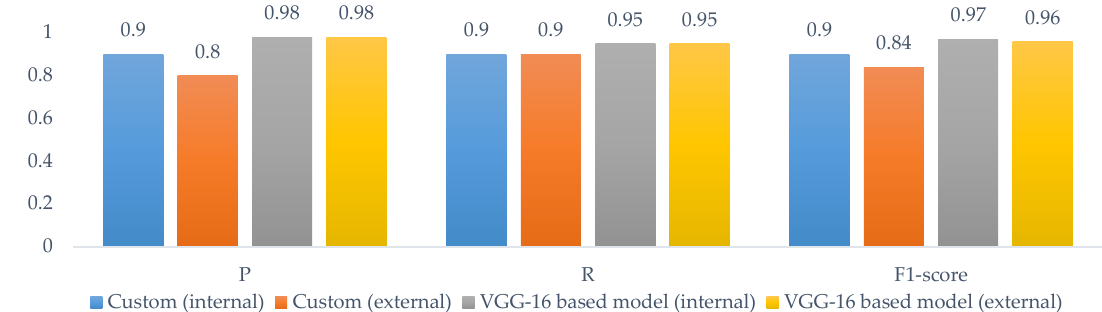
Figure 9. Performance evaluation of the custom model and the transfer-learning-based model: P, R, and F1-score (the higher the better).